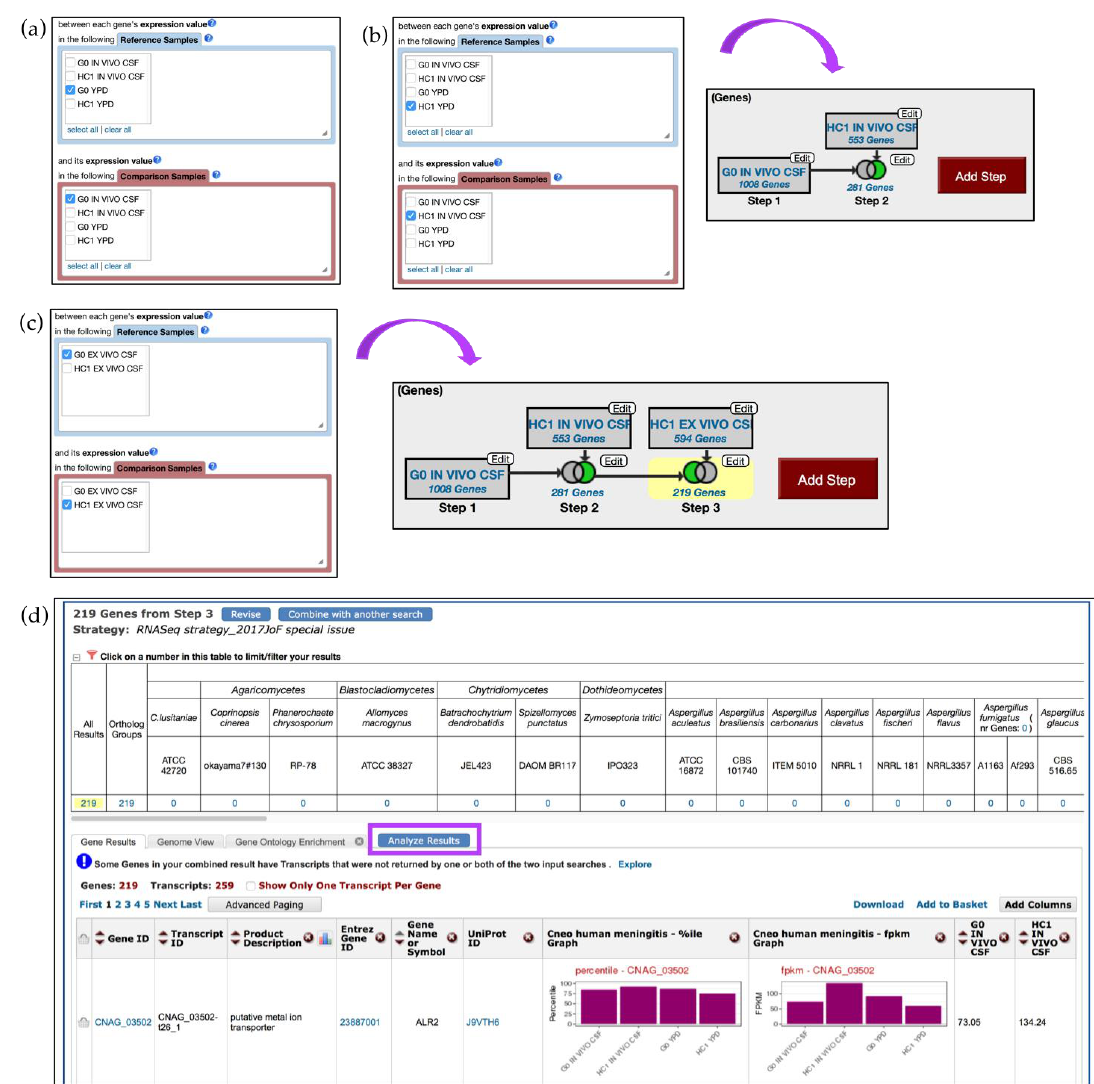
Figure 7. RNA-Seq query using C. neoformans single-read and paired-end datasets by Chen et al. [24] ( a ) RNA-Seq query on single-read data is initiated from the Search for Genes panel, Transcriptomics menu. Step 1 selects for two-fold up-regulated genes in G0 in vivo CSF compared with in the G0 YPD reference sample; ( b ) Step 2 selects for HC1 genes expressed in vivo CSF (using HC1 YPD sample as reference). Choose the 2 minus 1 intersect parameter to set up conditions for the final search; ( c ) Add